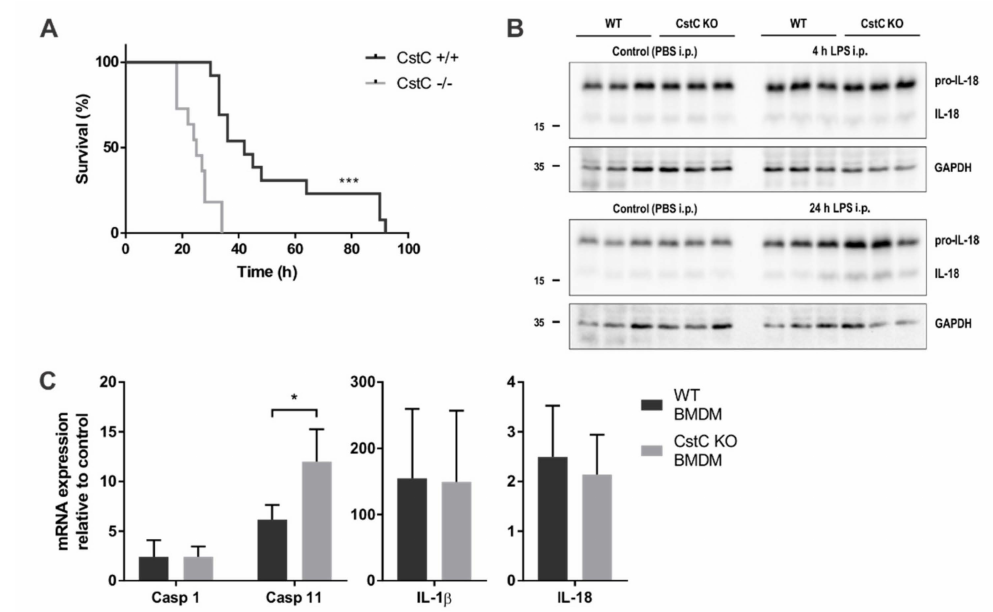
Figure 1. LPS-induced lethality and LPS-triggered pro-inflammatory cytokine and caspase expression is cystatin C-dependent. ( A ) Kaplan–Meier plot showing percentage of survival over time of age- matched wild-type (WT) (n = 13) and CstC KO mice (n = 11). *** p < 0.001 (log-rank (Mantel–Cox) test). Mice were injected intraperitoneally with 30 mg/kg LPS, and survival was monitored six times daily for a total of 4 days. ( B ) WT and CstC KO mice were injected with LPS at 5 mg/kg body weight for 4 h or 24 h and with PBS at 5 mL/kg body weight for 24 h for negative control. After LPS stimulation, mice were sacrificed and their spleens collected for Western blot analysis. Organ lysates were immunoblotted with indicated antibodies. Data shown are cropped blot images representative of three independent experiments. ( C ) BMDMs were stimulated with LPS (100 ng/mL) for 4 h and total RNA was isolated. Relative mRNA expression was determined, normalized to reference genes Gapdh and B2m and presented as fold increase compared to unstimulated (control) samples. Data were obtained from three independent experiments performed in triplicate, and the results are presented as means ± S.D. * p < 0.05, *** p <